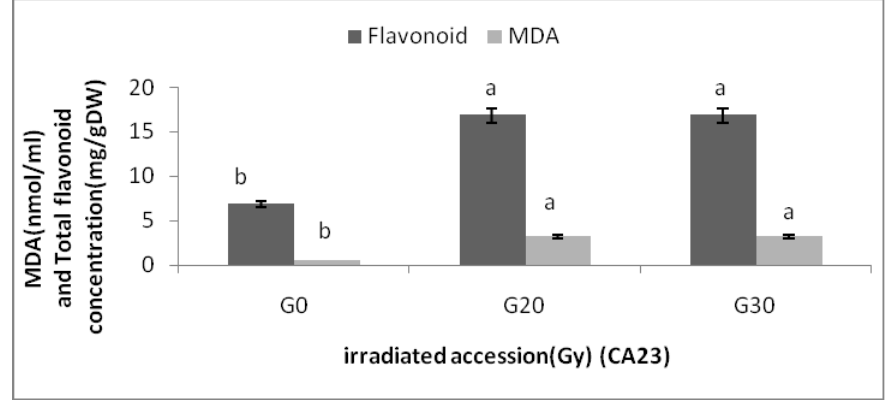
Figure 5. Flavonoid content and MDA in irradiated and non-irradiated accessions of CA23 n = 3 (CA23G20 = CA23 irradiated to 20 Gy; CA23G30 = CA23 irradiated to 30 Gy).